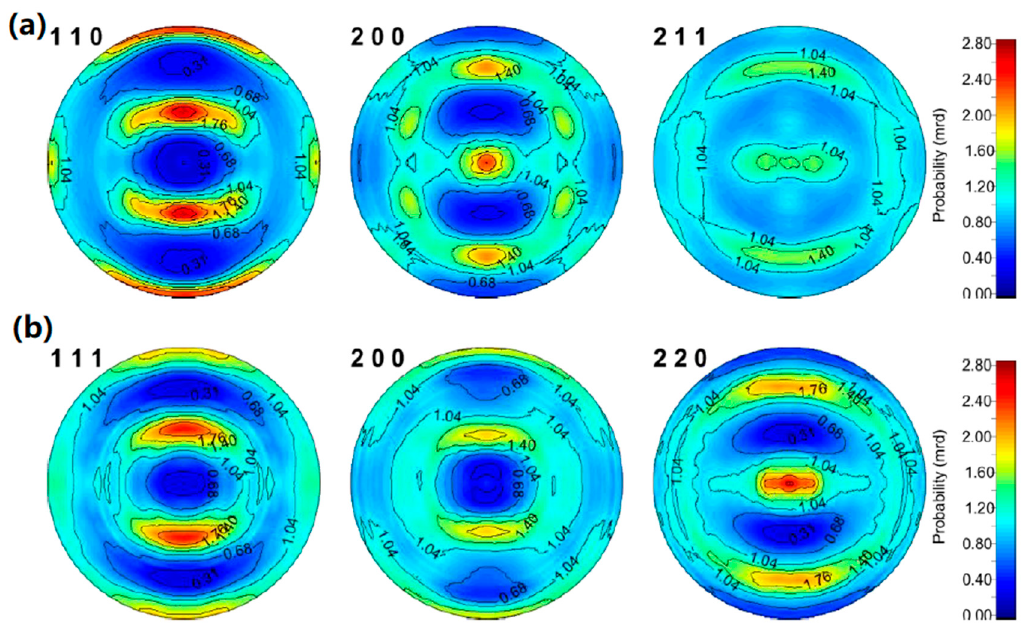
Figure 8. Reconstructed pole figures of martensite–austenite multilayered steel analyzed using the neutron diffractograms obtained with multiple wavelengths, λ 1 = 1.54 Å, k 1 = 4.08 Å − 1 , and λ 2 = 2.41 Å, k 2 = 2.61 Å − 1 : ( a ) Martensite layers, minimum pole distribution density I min = 0.16 multiples of mean random distribution (m.r.d.), maximum pole distribution density I max = 2.98 m.r.d.; ( b ) Austenite layers, I min = 0.14 m.r.d., I max = 3.35